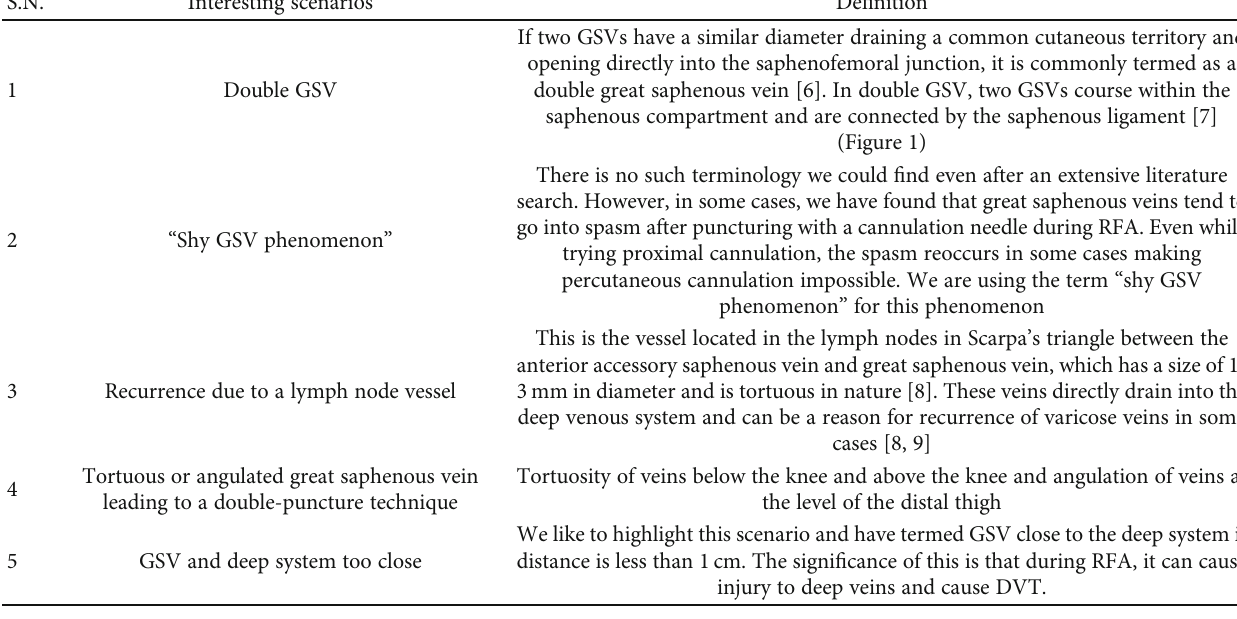
Table 1: Possible interesting scenarios during RFA of varicose veins.